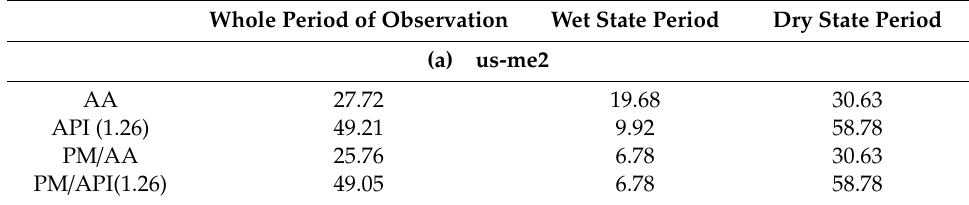
Table 6. RMSE (mm) the four applied models using Rn and G derived from empirical relationships. Errors are computed on monthly AET time series for the dry state period (AA = the advection-aridity method; API (1.26) = the API corrected potential evapotranspiration with α = 1.26; PM/AA = the Penman/advection-aridity threshold model; PM/API(1.26) = the Penman/API corrected potential evapotranspiration threshold model with α = 1.26; PM/API CAL = Penman/API corrected potential evapotranspiration calibrated threshold model).